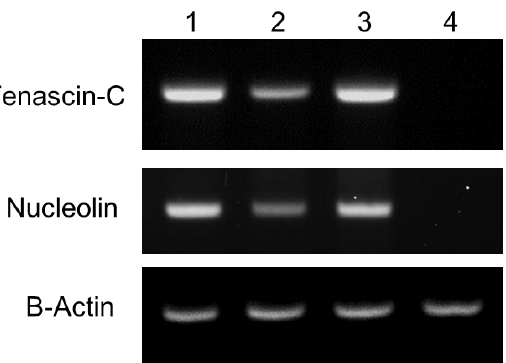
Figure 4. Reverse Transcription-Polymerase Chain Reaction (RT-PCR) analysis of the expression of tenascin-C and nucleolin in four cell lines. Lane 1, DU145 cells; lane 2, U-87 MG cells; lane 3, A549 cells; lane 4, CHO